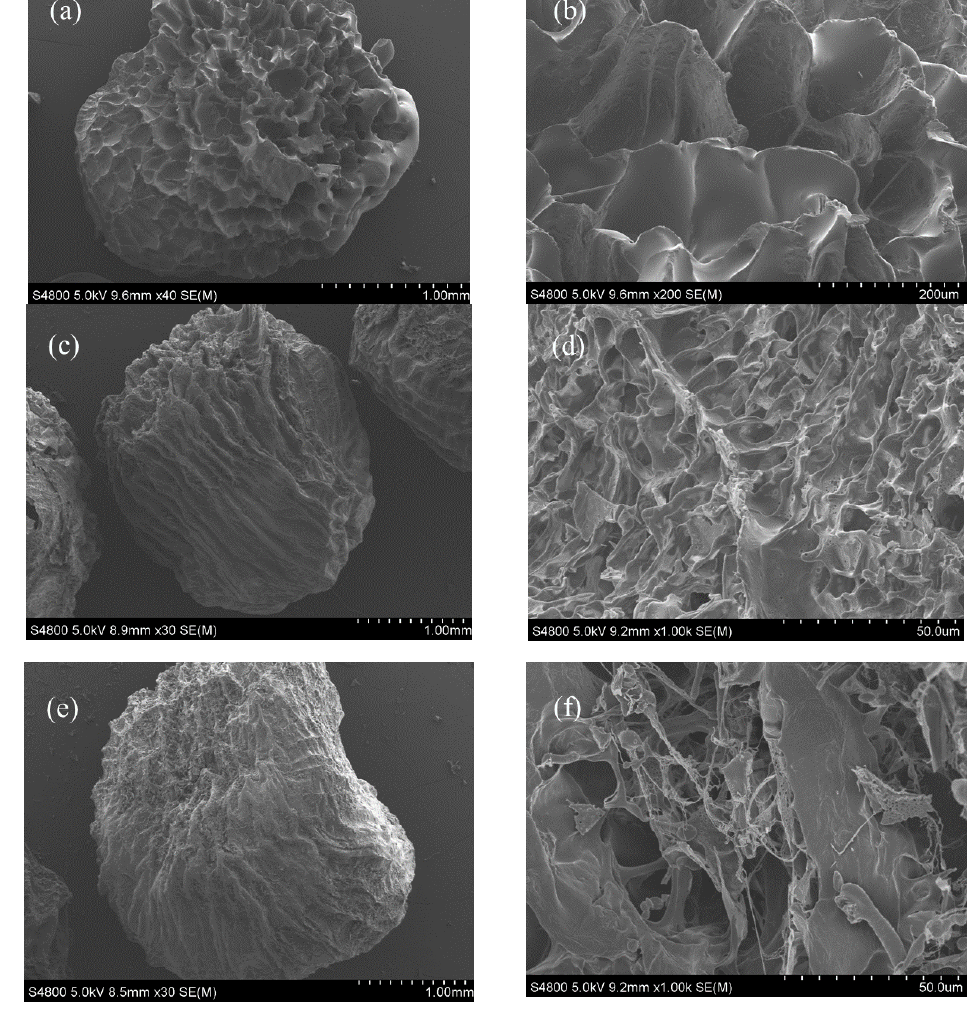
Figure 4. SEM of hydrogel beads: ( a , b ) SA beads at different magnifications ( ×40, ×200). ( c , d ) SAP13 beads at different magnifications (×30, ×1000). ( e , f ) SAPK2 beads at different magnifications (×30, beads at di ff erent magnifications ( × 30, × 1000). ( e , f ) SAPK2 beads at di ff erent magnifications ( × 30, ×1000). ×